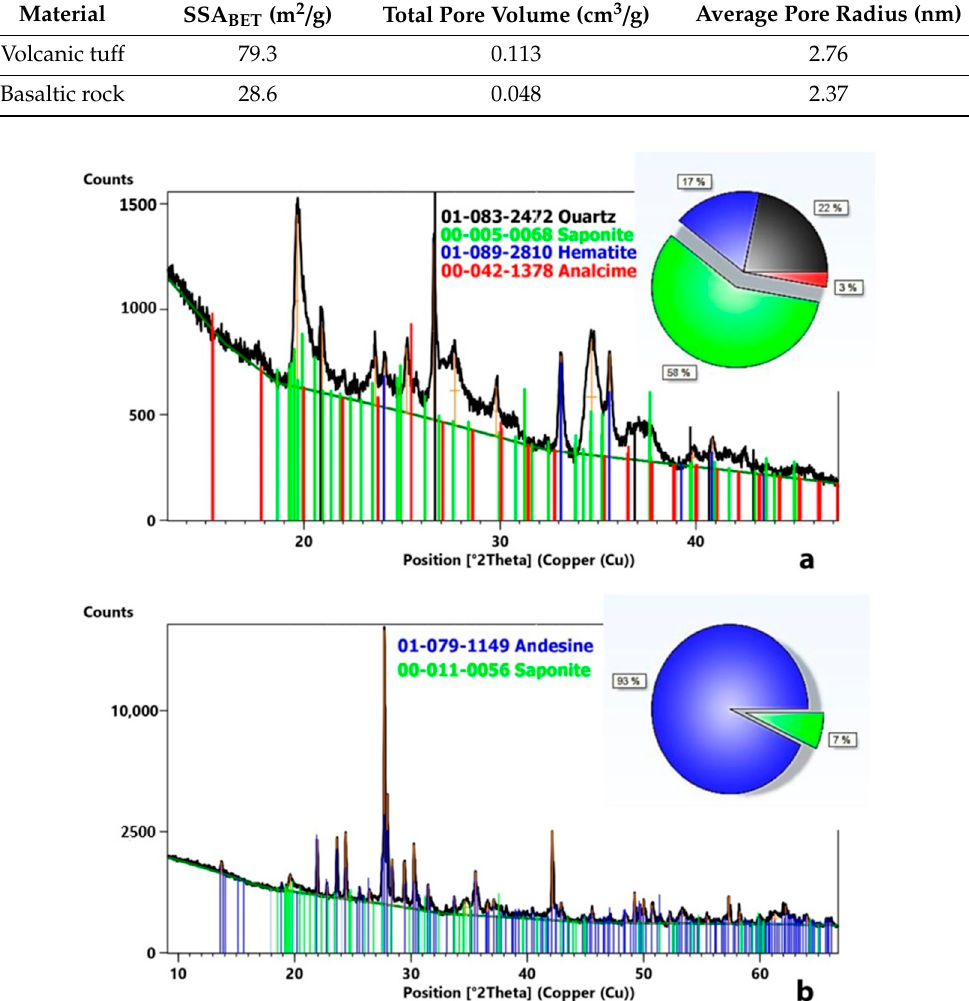
Figure 1. X-ray diffraction patterns of ( a ) tuff and ( b ) basalt. Reprinted with permission from Figure 1. X-ray di ff raction patterns of ( a ) tu ff and ( b ) basalt. Reprinted with permission from Reference [25]. Reference Table 2. Structure parameters of volcanic tuff and basalt from Ivanodolinsky quarry [25].